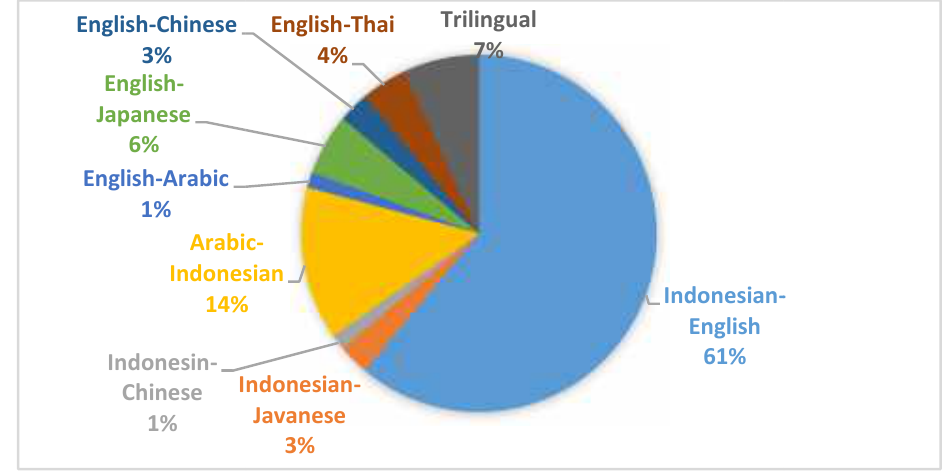
Figure 3. Bilingual and Trilingual Signs in the LL of Sidoarjo